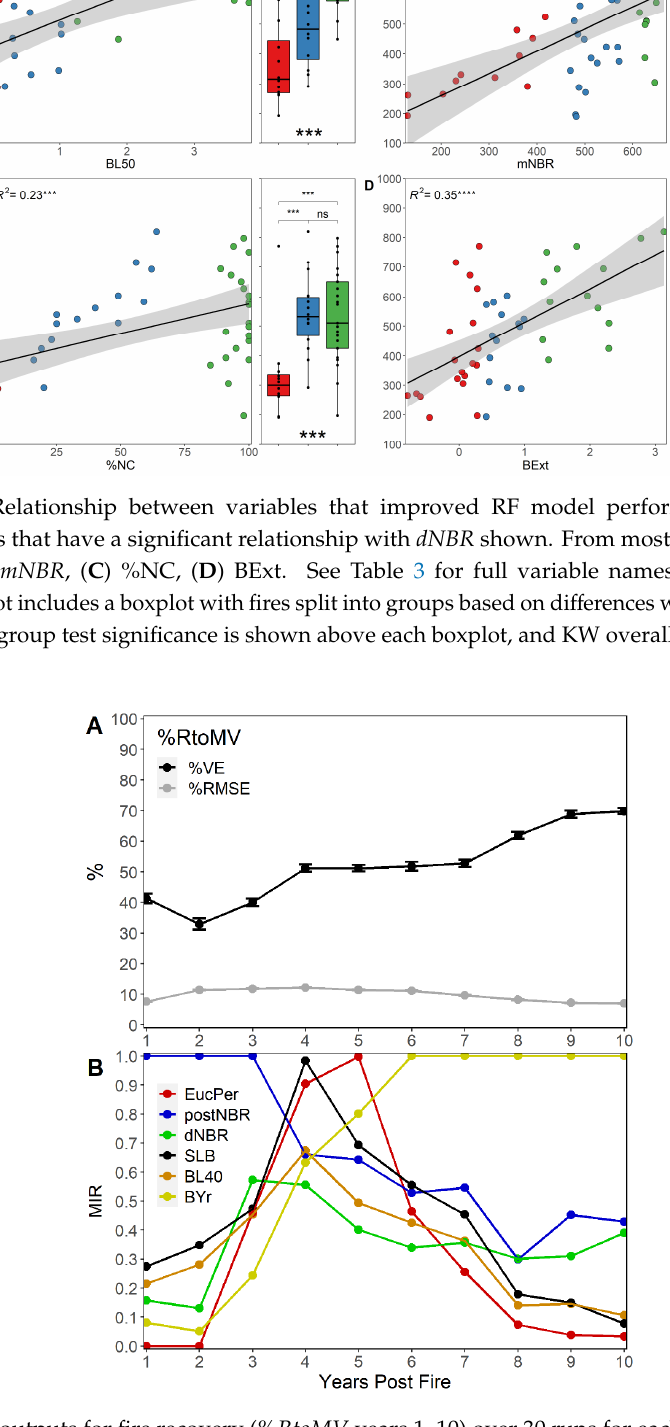
Figure 12. RF outputs for fire recovery ( %RtoMV years 1–10) over 30 runs for each year. ( a ) Overall model results over time (Mean ± SD). ( b ) Variable importance over time as quantified by MIR. SD bars are not included here to make the figure legible. See Table 3 for full variable names and descriptions. EucPer is the percentage of burned pixels in each fire comprised of the eucalypt woodlands vegetation group (Figure 8b).